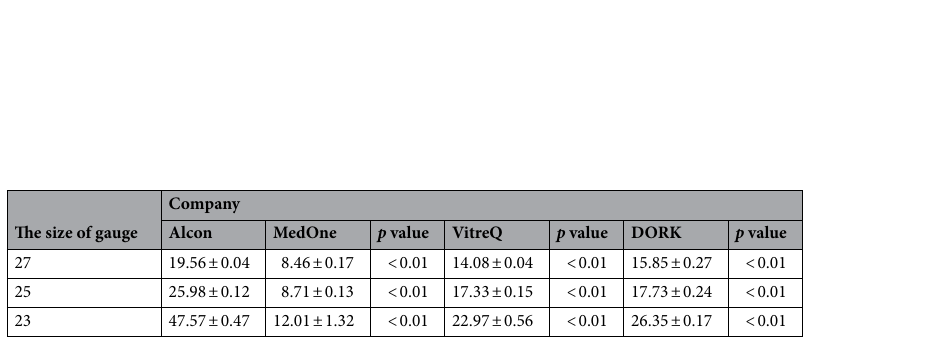
Table 1. Comparison of aspiration rate (cc/min) in each backflush